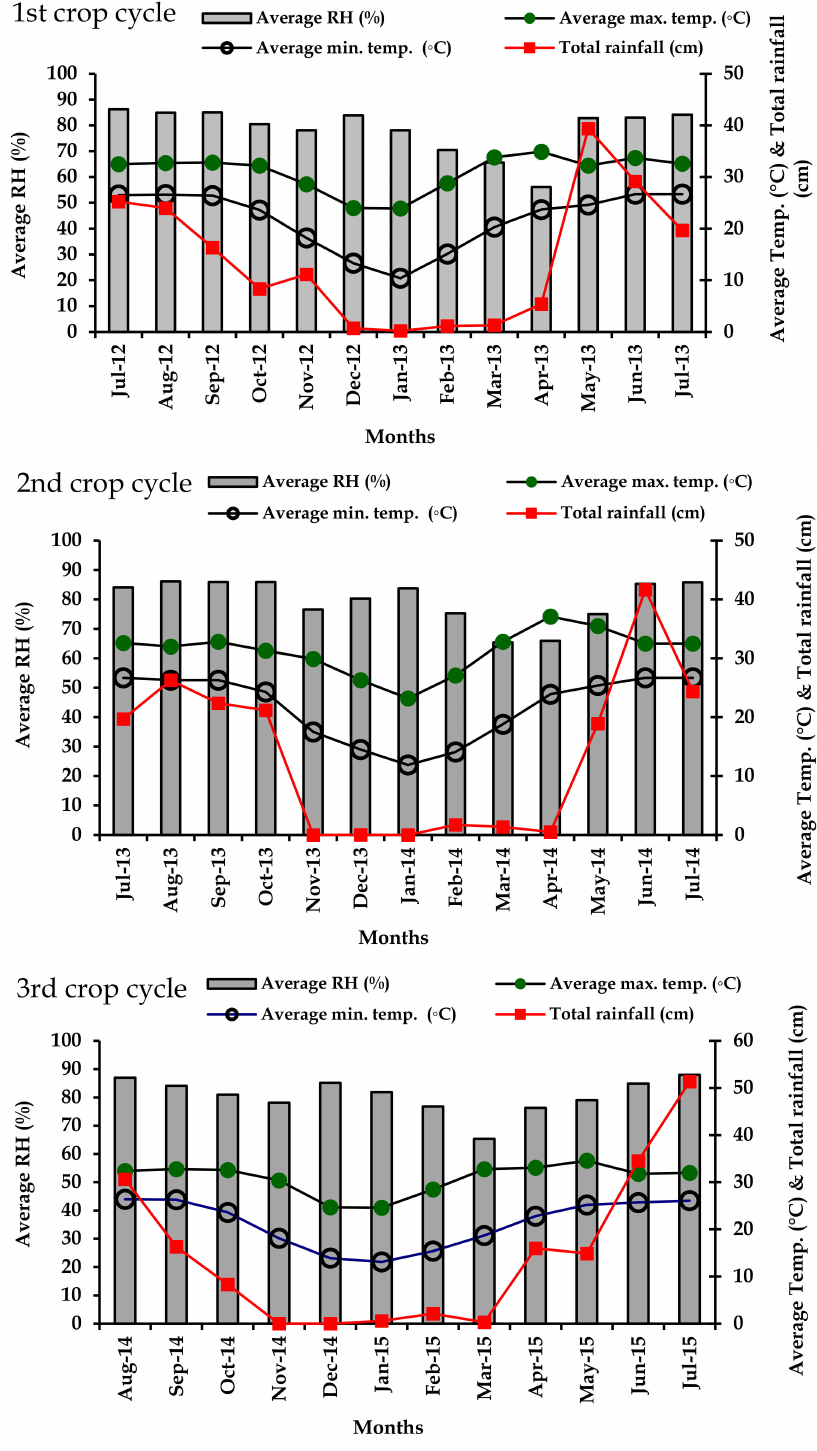
Figure 1. Weather data during the cropping